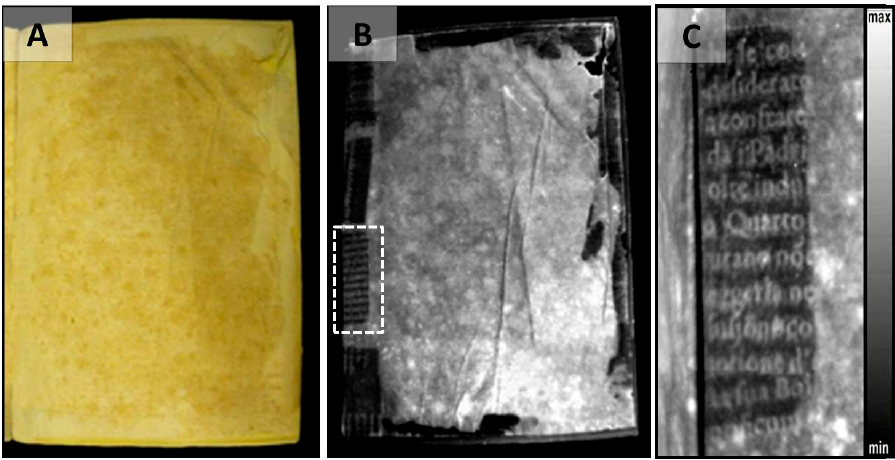
Figure 7. XVI century book, Biblioteca Angelica of Rome. ( A ) Photograph and ( B ) corresponding thermogram; ( C ) magnification of the dashed area in 7B